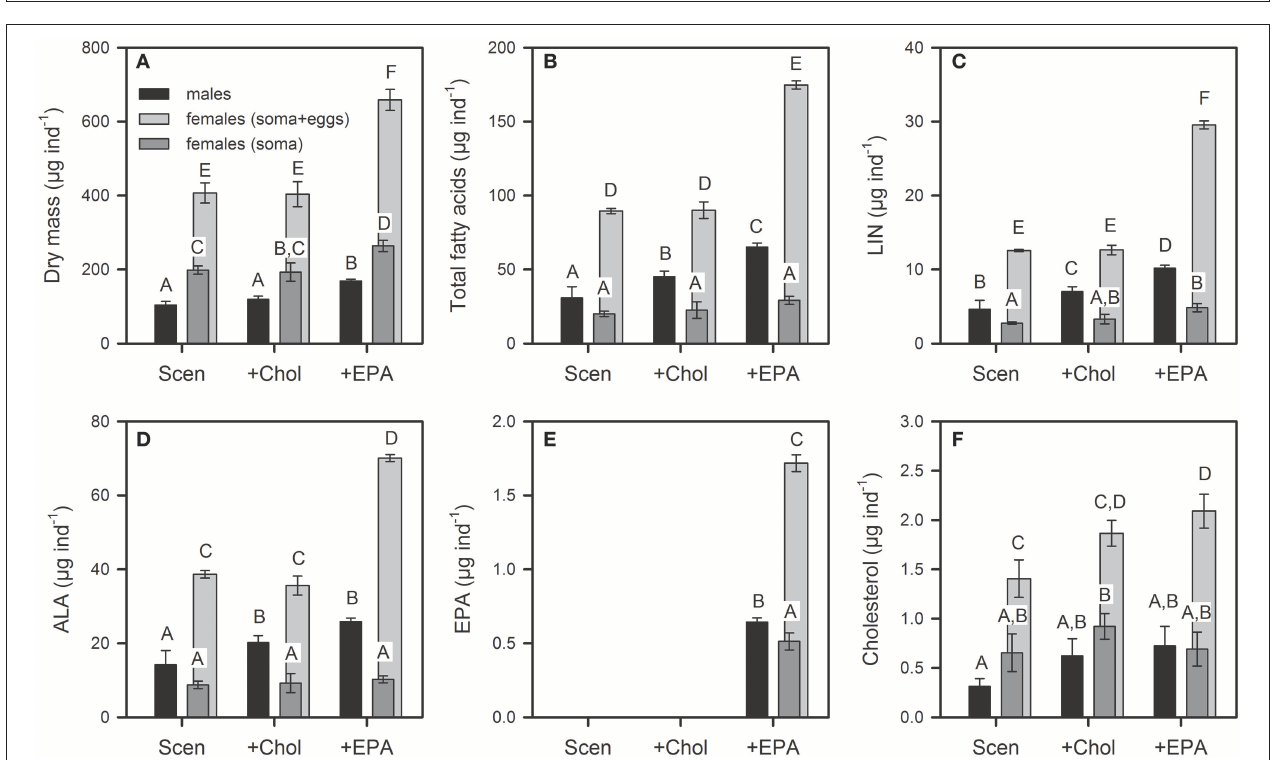
FIGURE 5 | Clutch size (A) , egg dry mass (B) , and total maternal dry mass investment (C) in the first three reproduction cycles of D. magna reared on S. obliquus and S. obliquus supplemented with cholesterol or EPA. Data represent means of n = 6 ± SD. Data points labeled with the same letters are not significantly different (Tukey’s HSD, P < 0.05, following ANOVA; Table S2).